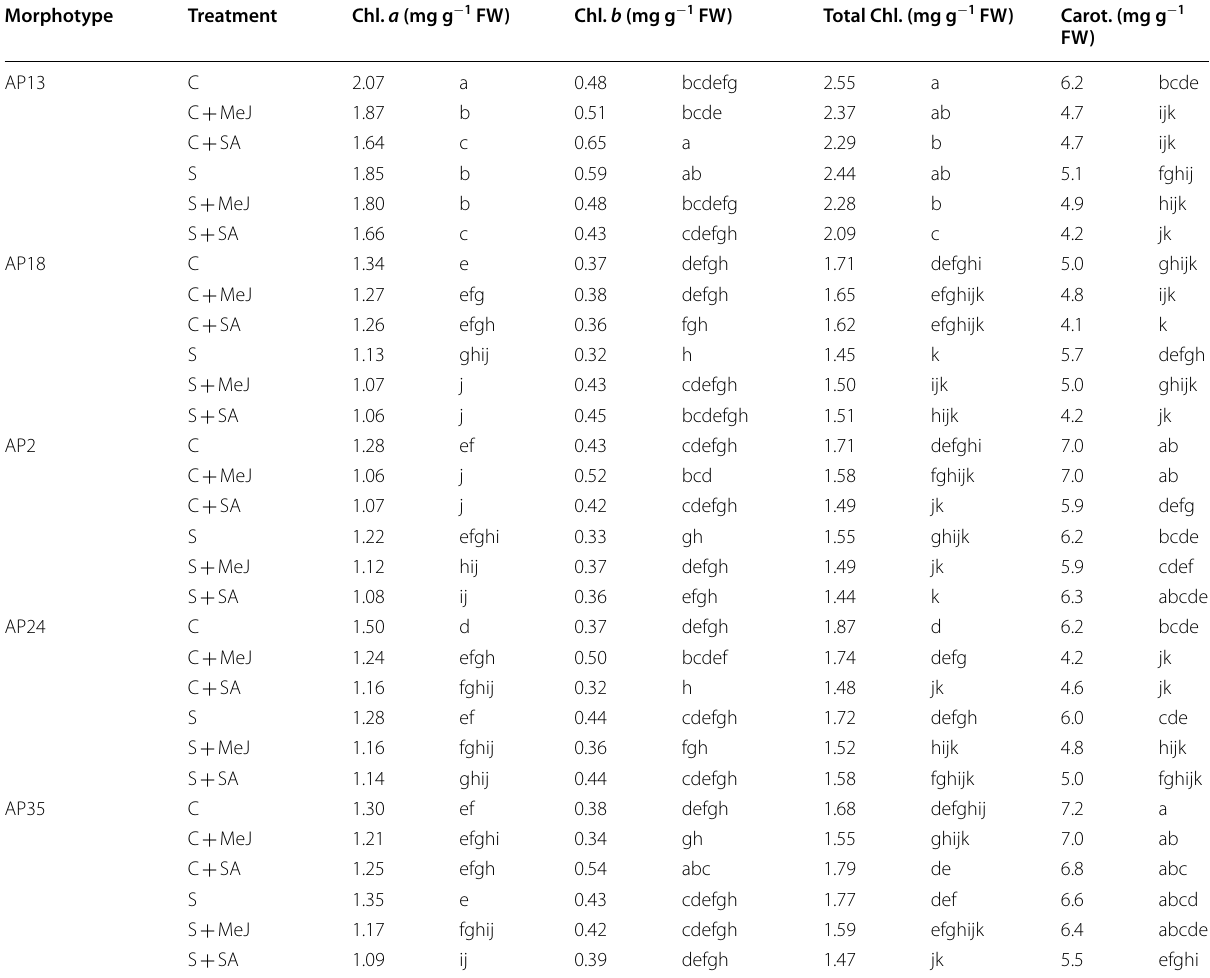
Table 3 Photosynthetic pigments content in leaves of Andrographis paniculata at 140